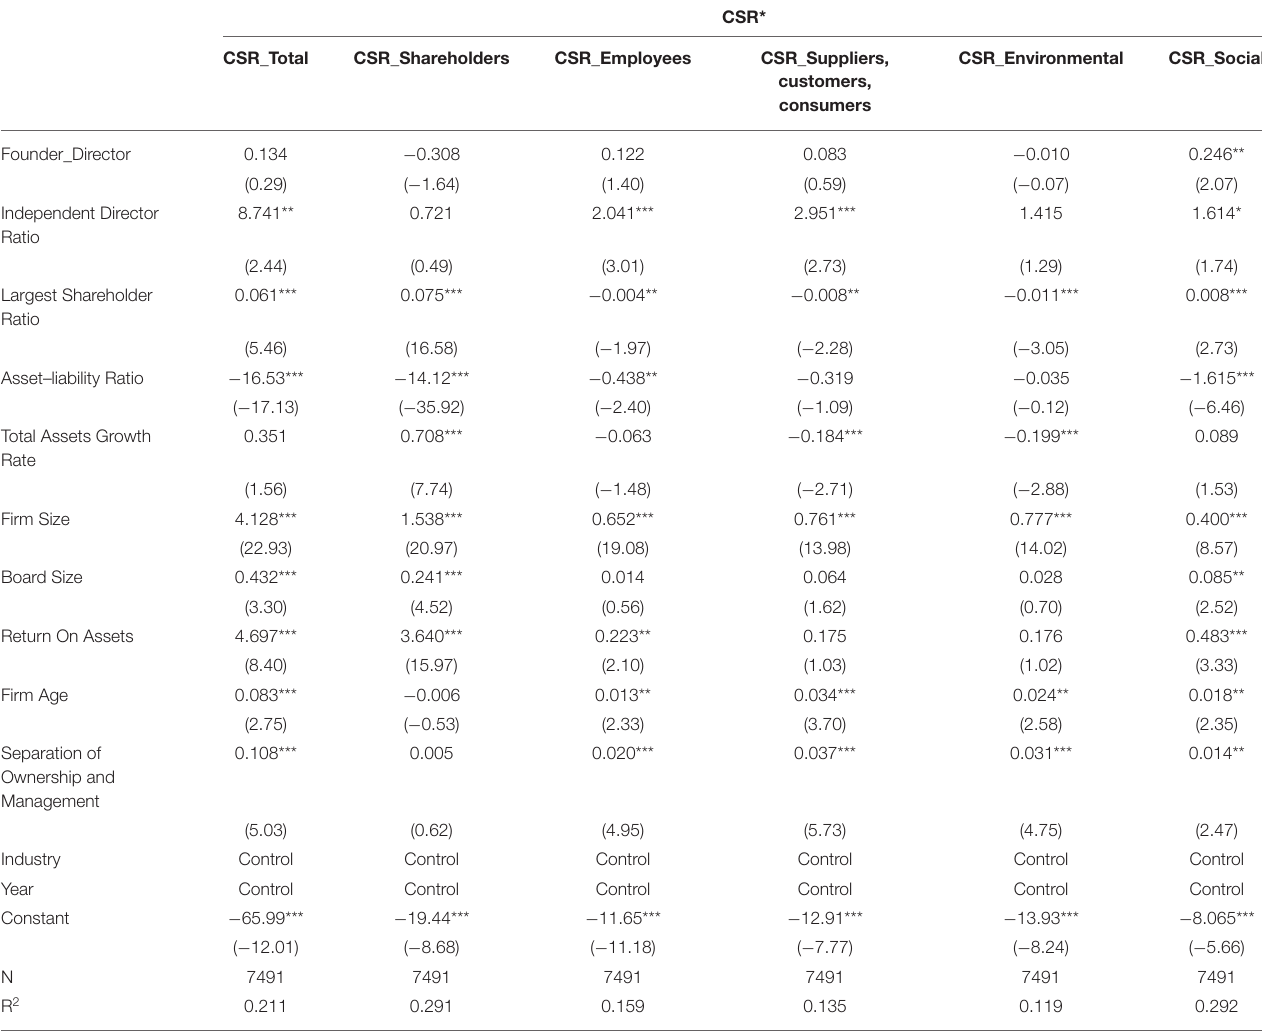
TABLE 11 | Regression results (founder director and